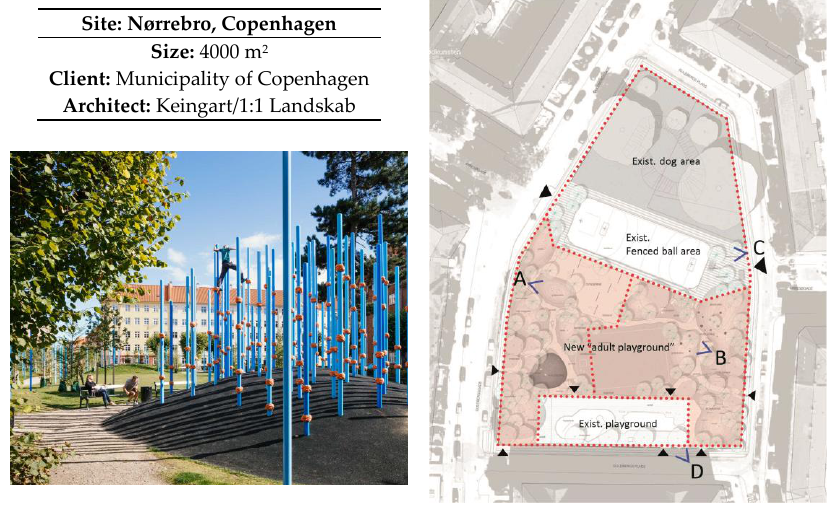
Figure 2. Overview of the Guldbergs Plads. In order to make manageable observations, the space was divided in to four sub-areas. Sub-areas A and B cover the new part of the park, while sub-area C covers the existing ball area and dog area. Sub-area D covers an existing playground. The angle explains the observer’s position and field of view during the observations.